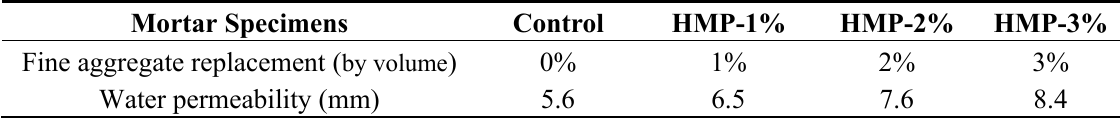
Table 6. Water permeability results of the HMP